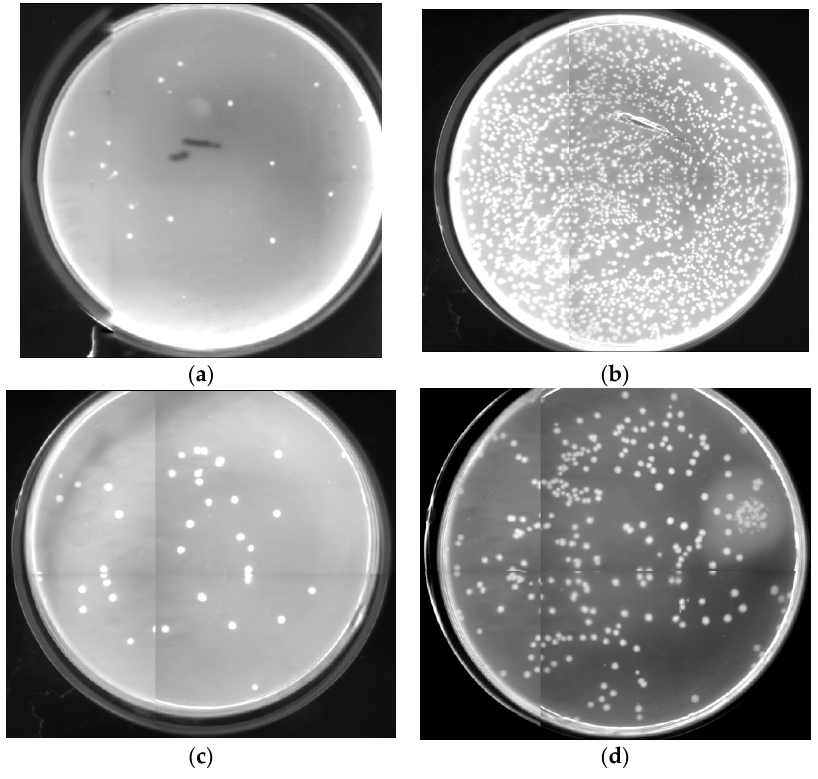
Figure 5. Antibacterial assay on Petri dishes: Staphylococcus aureus ATCC (American type culture collection) 653 incubated with the co-immobilised enzymes ( a ); Staphylococcus aureus ATCC 653 incubated with NH 2 -Silica ( b ); Escherichia coli ATCC 1122 incubated with the co-immobilised enzymes ( c ); Escherichia coli ATCC 1122 incubated with NH 2 -Silica ( d ).